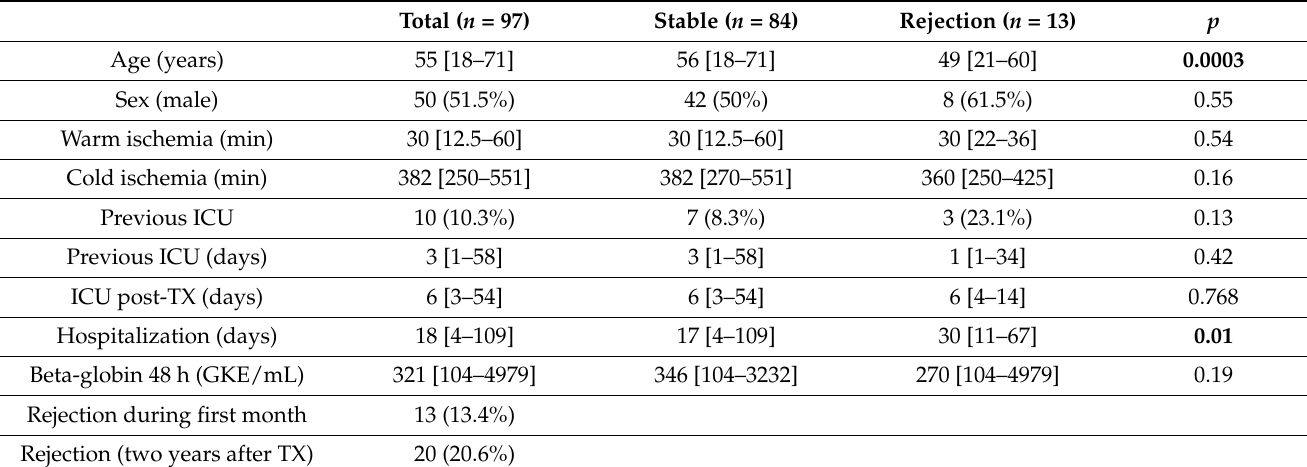
Table 1. General characteristic of the